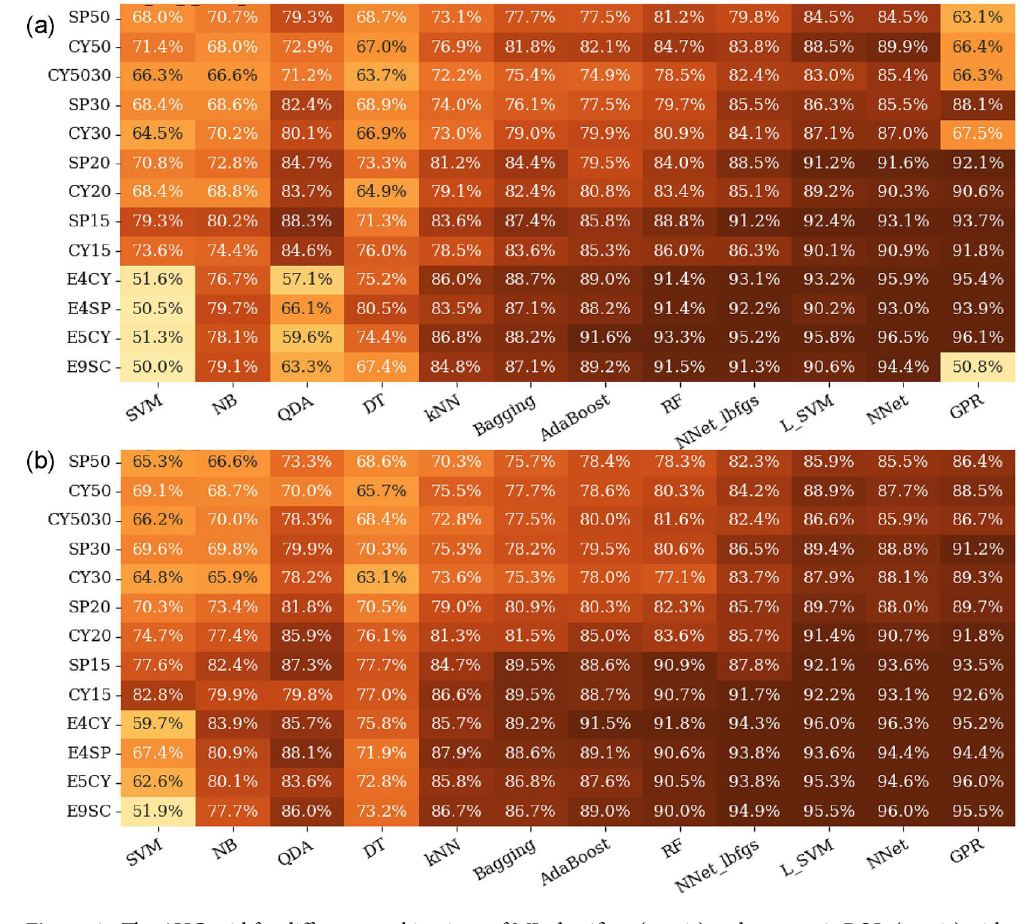
Figure 6. The AUC grid for different combinations of ML classifiers (x-axis) and geometric ROIs (y-axis) with various sizes and shapes ( a ) with no FS method and ( b ) with LASSO as the FS method.